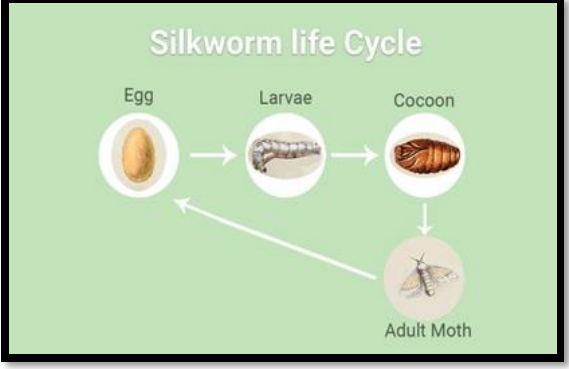
Figure 8. The different stages of silkworms.